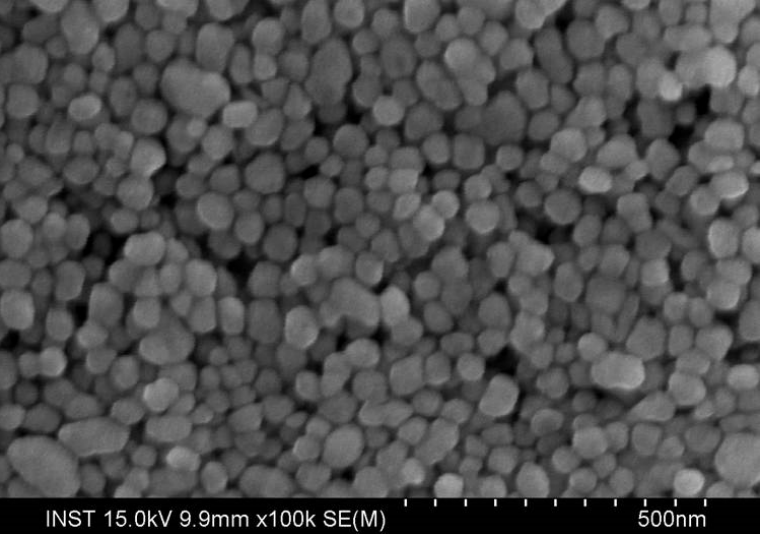
Figure 1. Field emission scanning electron microscope (FE-SEM) image of silver nanoparticles before sintering.